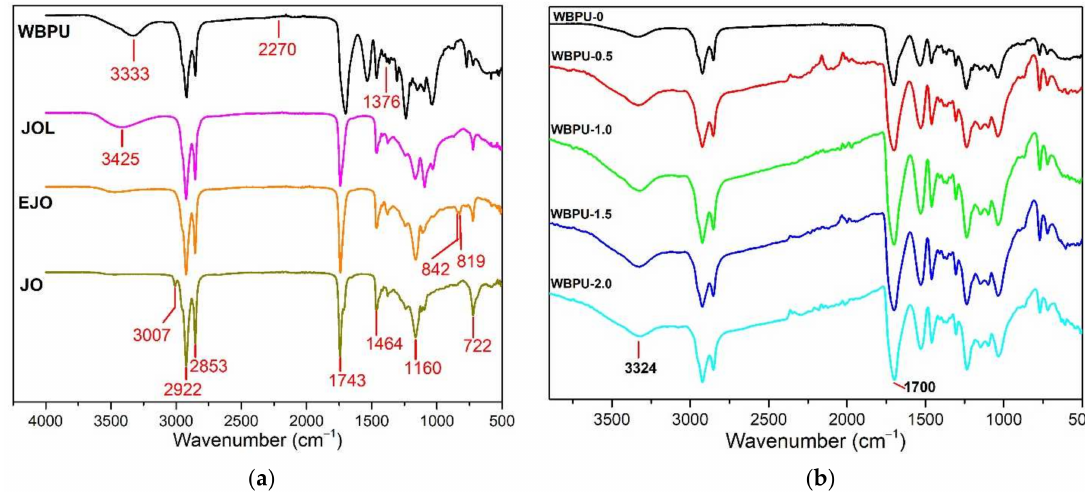
Figure 3. ( a ) FTIR spectra of derivation of WBPU from jatropha oil; ( b ) FTIR spectra of WBPU, WBPU-0, WBPU-0.5, WBPU-1.0, WBPU-1.5 and